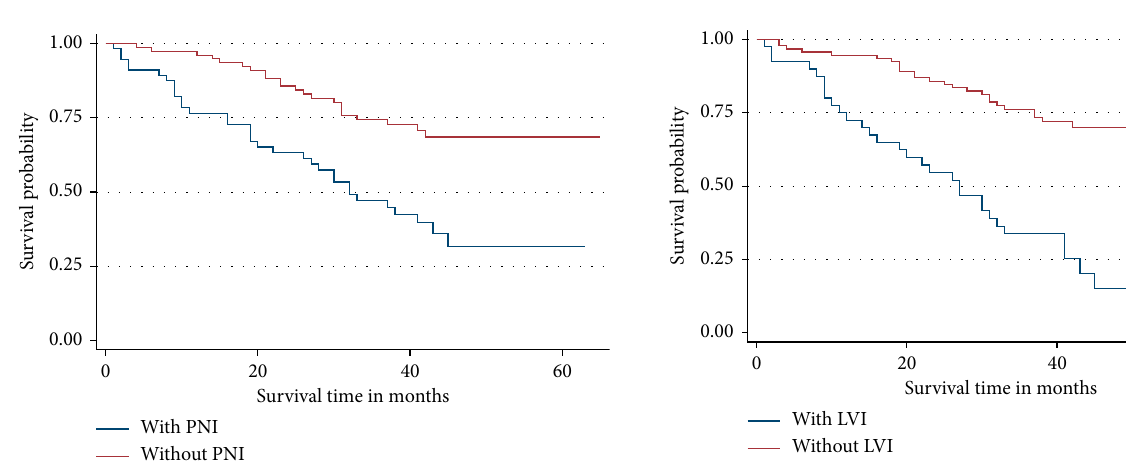
Figure 8: Overall survival by lymphovascular invasion (LVI). LVI was predicting the overall survival